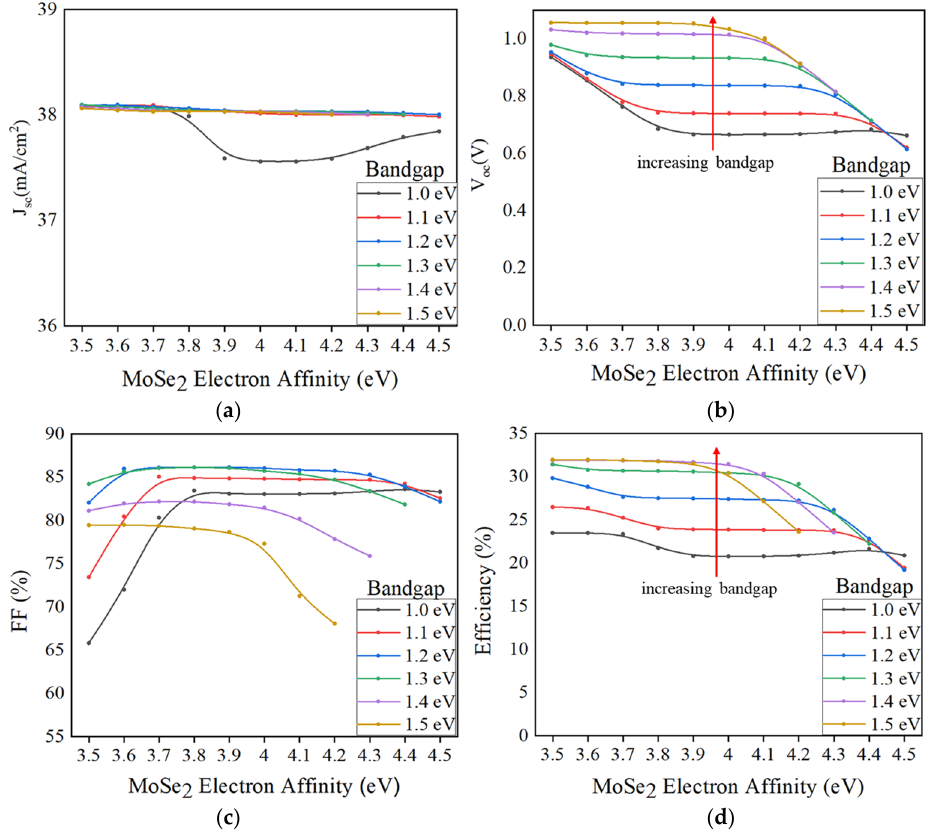
Figure 6. The simulated electrical performance parameters as a function of MoSe 2 electron affinity ranging from 3.5 eV to 4.5 eV: ( a ) J SC ; ( b ) V OC ; ( c ) FF; and ( d ) conversion efficiency (PCE) at different bandgap ranging from 1.0 eV to 1.5 eV.